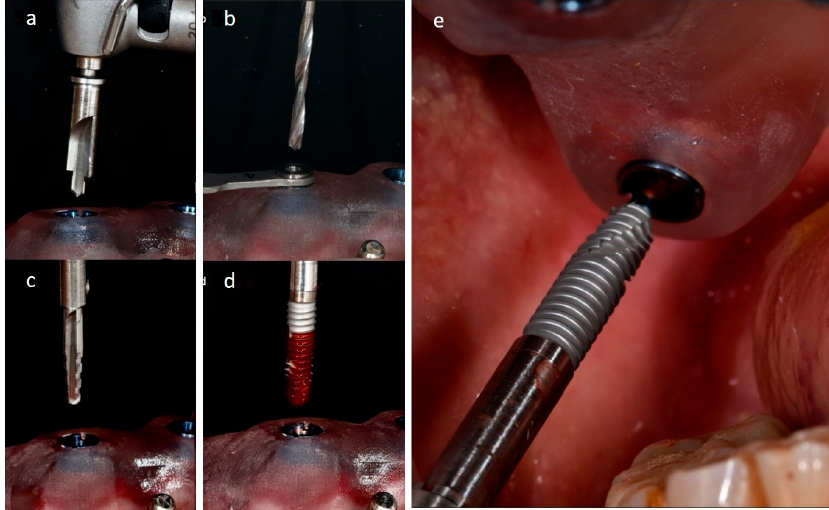
Figure 5. Pterygoid implant beds’ preparation with the printed surgical guide fixed in place: the cortical perforator ( a ), the following twist drill ( b ), the shaping drill burs ( c ), and the implant seating with the implant carrier ( d , e